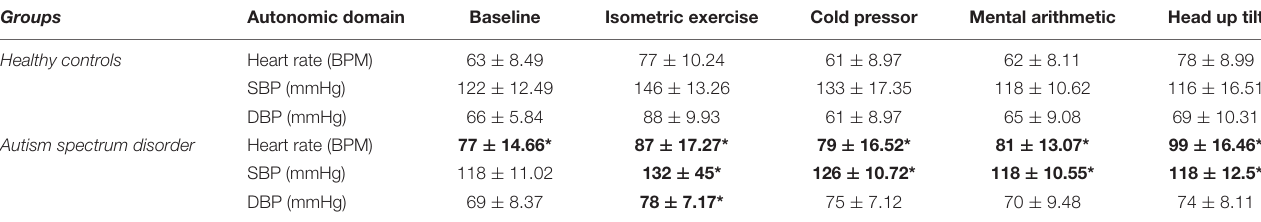
TABLE 2 | Summary of autonomic test data in controls and ASD. Groups